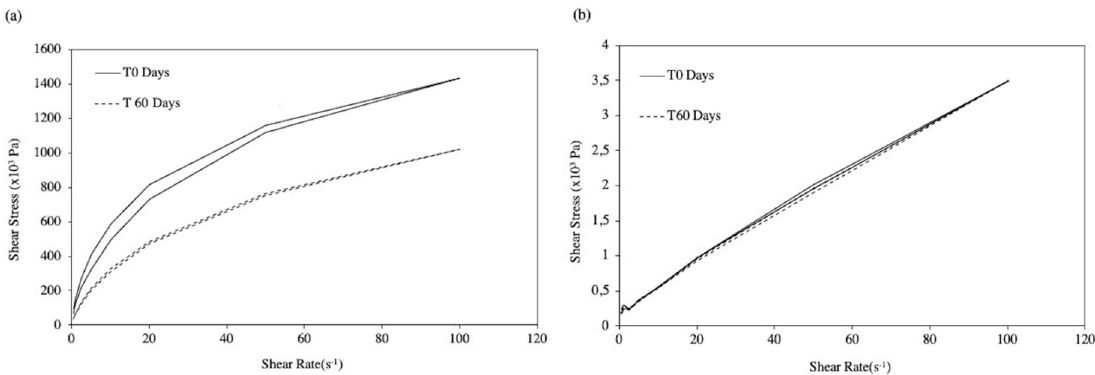
Figure 5. Flow curves of gel formulations F1-MH ( a ) and F2-MH ( b ) at room temperature along the stability study.